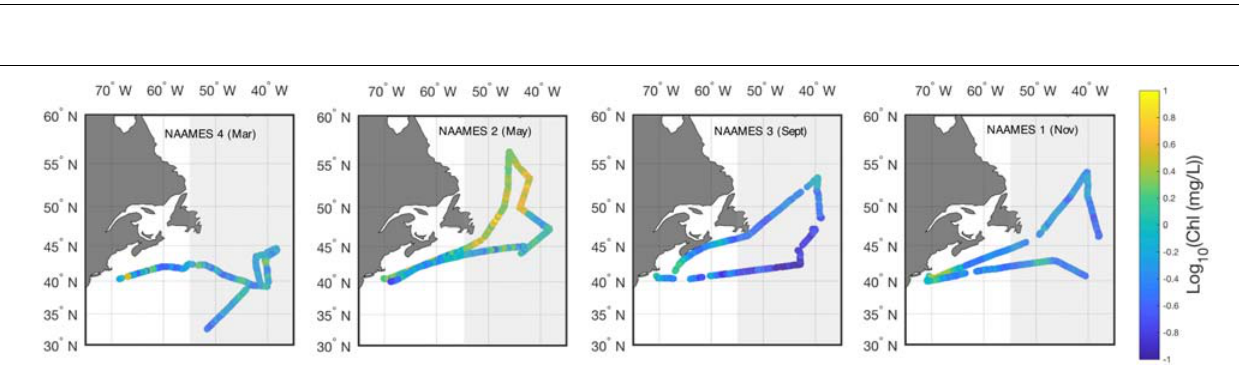
FIGURE 1 | Monthly average Log 10 surface chlorophyll a concentration for March, May, September, and November from year 5 of the CESM simulation. Black rectangle on the western side of the left panel (March) indicates region displayed in Figures 3 , 4 .